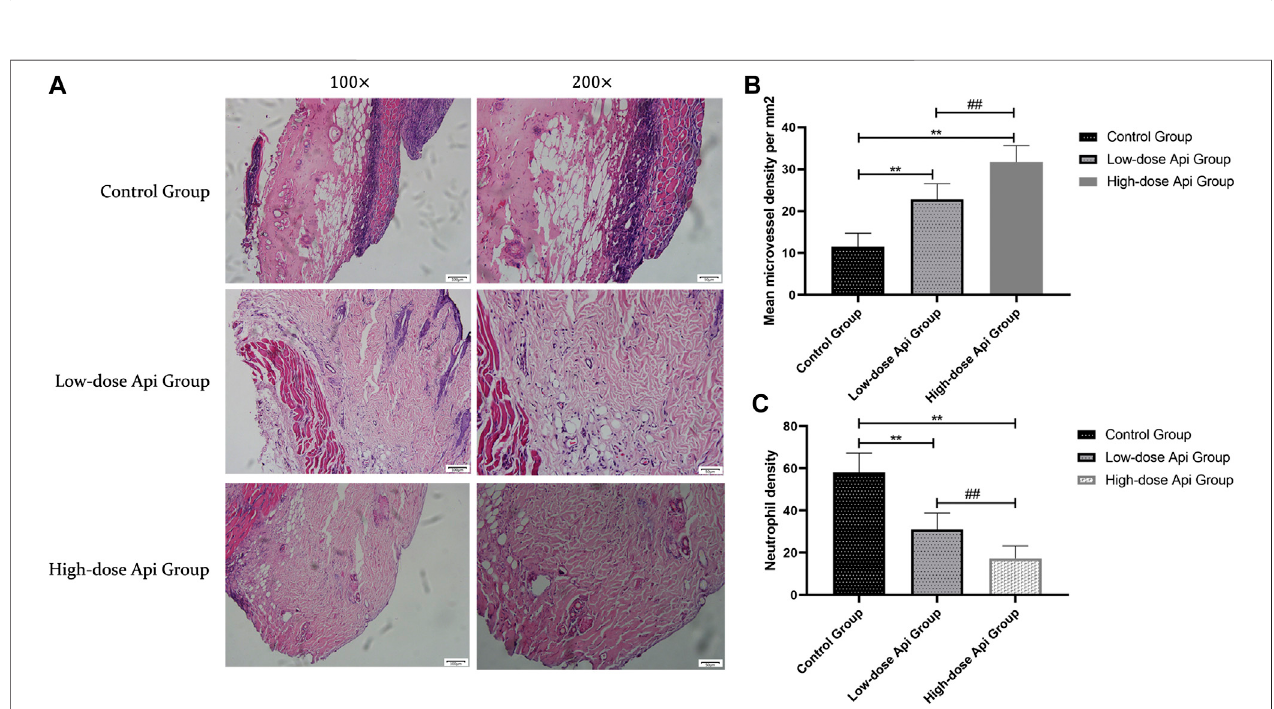
FIGURE 3 | (A) Histopathological features of the fl aps were assessed using hematoxylin and eosin (H&E) staining on day 7 after the operation; representative images acquired with a light microscope are shown (magni fi cation, × 100, × 200). Api reduced histopathological damage. (B) The microvascular density in zone 2 of the dorsal fl ap on day 7 after the operation. Api increased microvessel density. (C) Neutrophil density on day 7 after theoperation. Api reduced neutrophil density.** p < 0.01 vs. control group. ## p < 0.01 vs. Low-dose Api group.